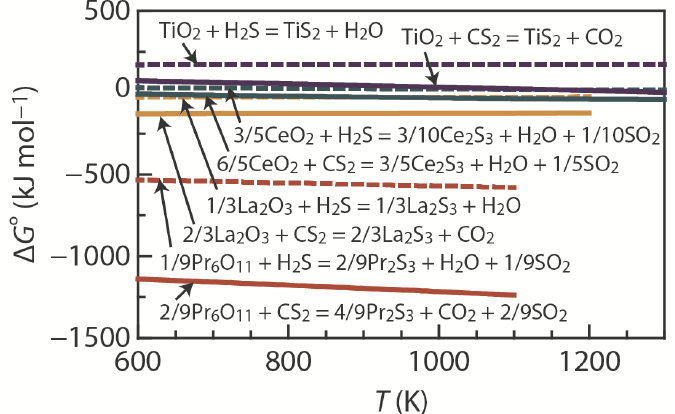
Figure 2. Temperature dependence of the standard free-energy change ( Δ G °) for the sulfurization of TiO 2 [29], La 2 O 3 , CeO 2 [51], and Pr 6 O 11 [52] with CS 2 and H 2